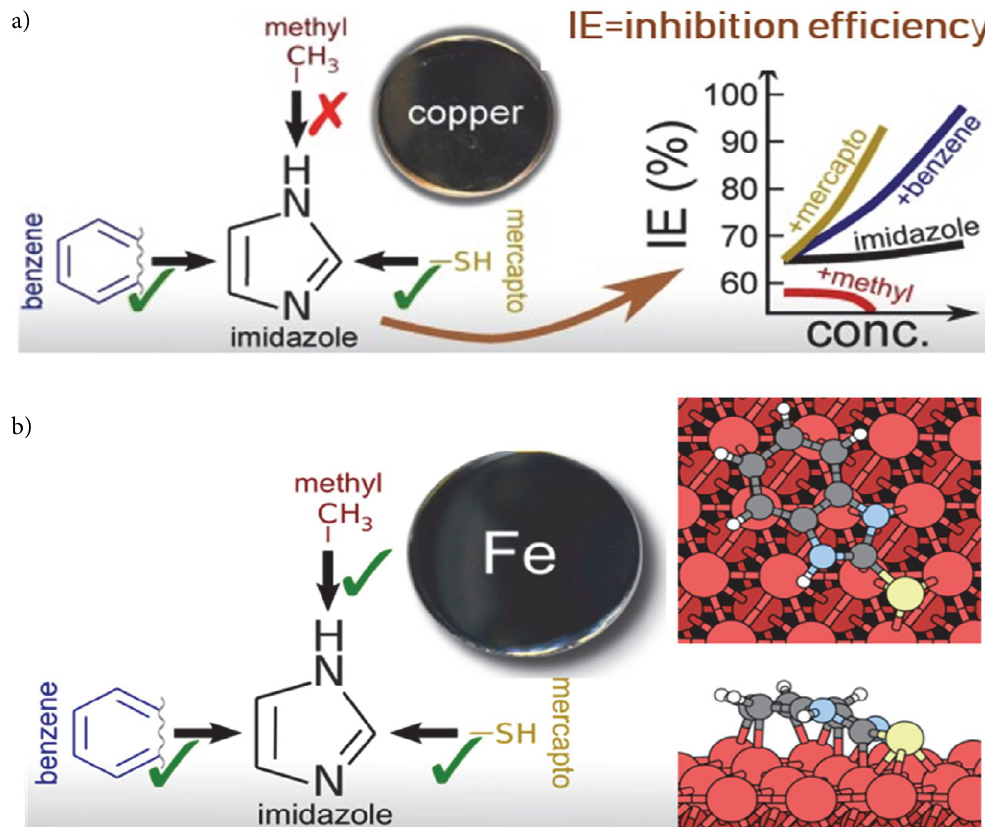
Figure 8. The inhibition efficiency as a function of imidazole derivative and substrate for (a) copper and (b) iron. (b) Optimized molecular adsorp- tion modes of SH-BimMe on iron surface. (a) Reprinted from the publication by I. Milošev, N. Kovačević, A. Kokalj, Corros. Sci., 2015 , 98, 107 − 118 with permission from Elsevier.